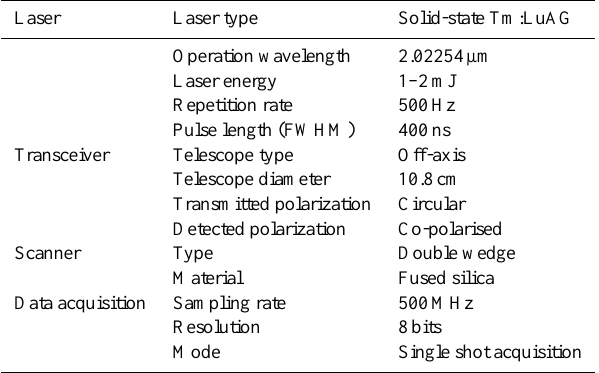
Table 1. Key parameters of the